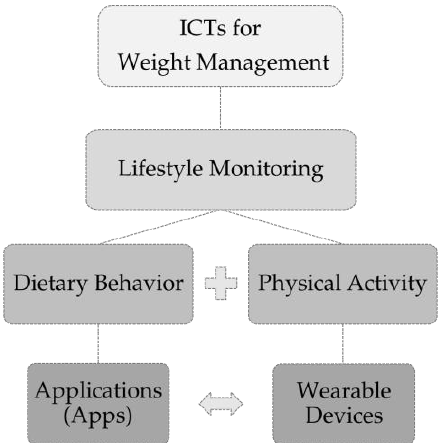
Figure 1. Novel information and communication technologies (ICTs) for lifestyle monitoring (diet; physical activity) and weight management. App = application on smartphones; wearable device = portable hardware/activity tracker.